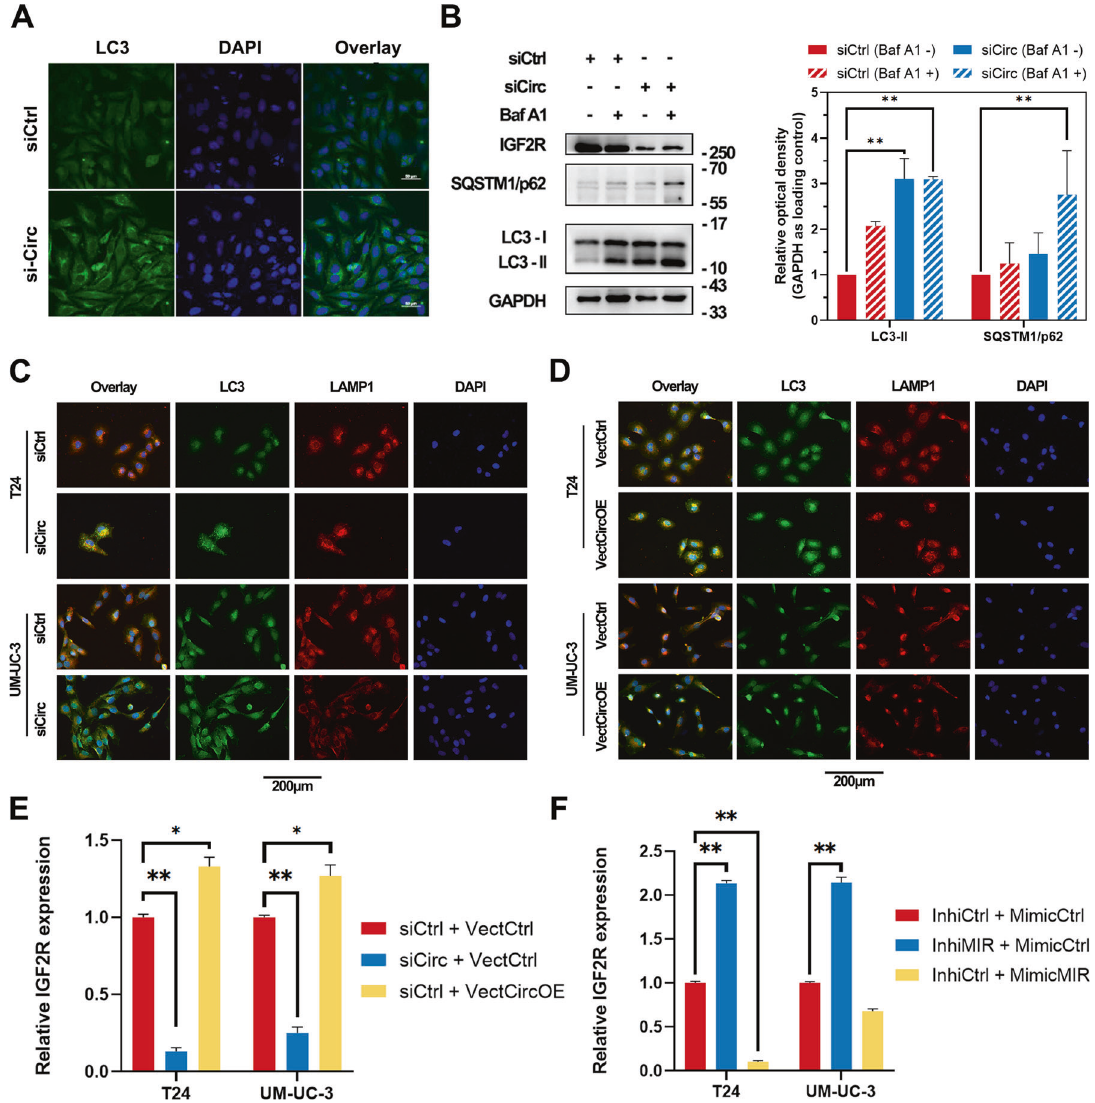
Fig. 5 CircRNA hsa_circ_0007813 regulated autophagy through hsa-miR-361-3p/IGF2R. A Immunocytochemical analysis of autophago- somes in UM-UC-3 cells transfected with siRNA (siCirc) or control siRNA (siCtrl). B At 48 h after siRNA transfection, UM-UC-3 cells were treated with Ba fi lomycin A1 (Baf A1) 50 nM or DMSO for 24 h. Western blot analysis showed the expression level of SQSTM/p62, LC3-I, and LC3-II. GAPDH was used as loading controls (Left panel). Quantitative analysis was conducted (Right panel, N = 3, Kruskal – Wallis test). C Immunocytochemical analysis of autophagosomes and lysosomes in T24 and UM-UC-3 cells transfected with siRNA (siCirc) or control siRNA (siCtrl). Anti-LC3 and anti-LAMP1 antibodies were used to mark autophagosomes (Green) and lysosomes (Red), respectively. D Immunocytochemical analysis of autophagosomes and lysosomes in T24 and UM-UC-3 cells transfected with hsa_circ_0007813 overexpression vectors (VectCircOE) or control vectors (VectCtrl). Anti-LC3 and anti-LAMP1 antibodies were used to mark autophagosomes (Green) and lysosomes (Red), respectively. The RNA expression pro fi les of IGF2R were measured by qRT-PCR in ( E ) hsa_circ_0007813 knockdown and overexpression cells ( N = 3, Kruskal – Wallis test), as well as ( F ) hsa-miR-361-3p downregulated and upregulated cells ( N = 3, Kruskal – Wallis test). All error bars in the fi gures indicated the standard deviation of three independent experiments. * P < 0.05, ** P < 0.01, *** P <